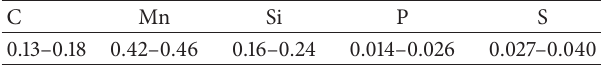
Table 1: Chemical compositions of steel